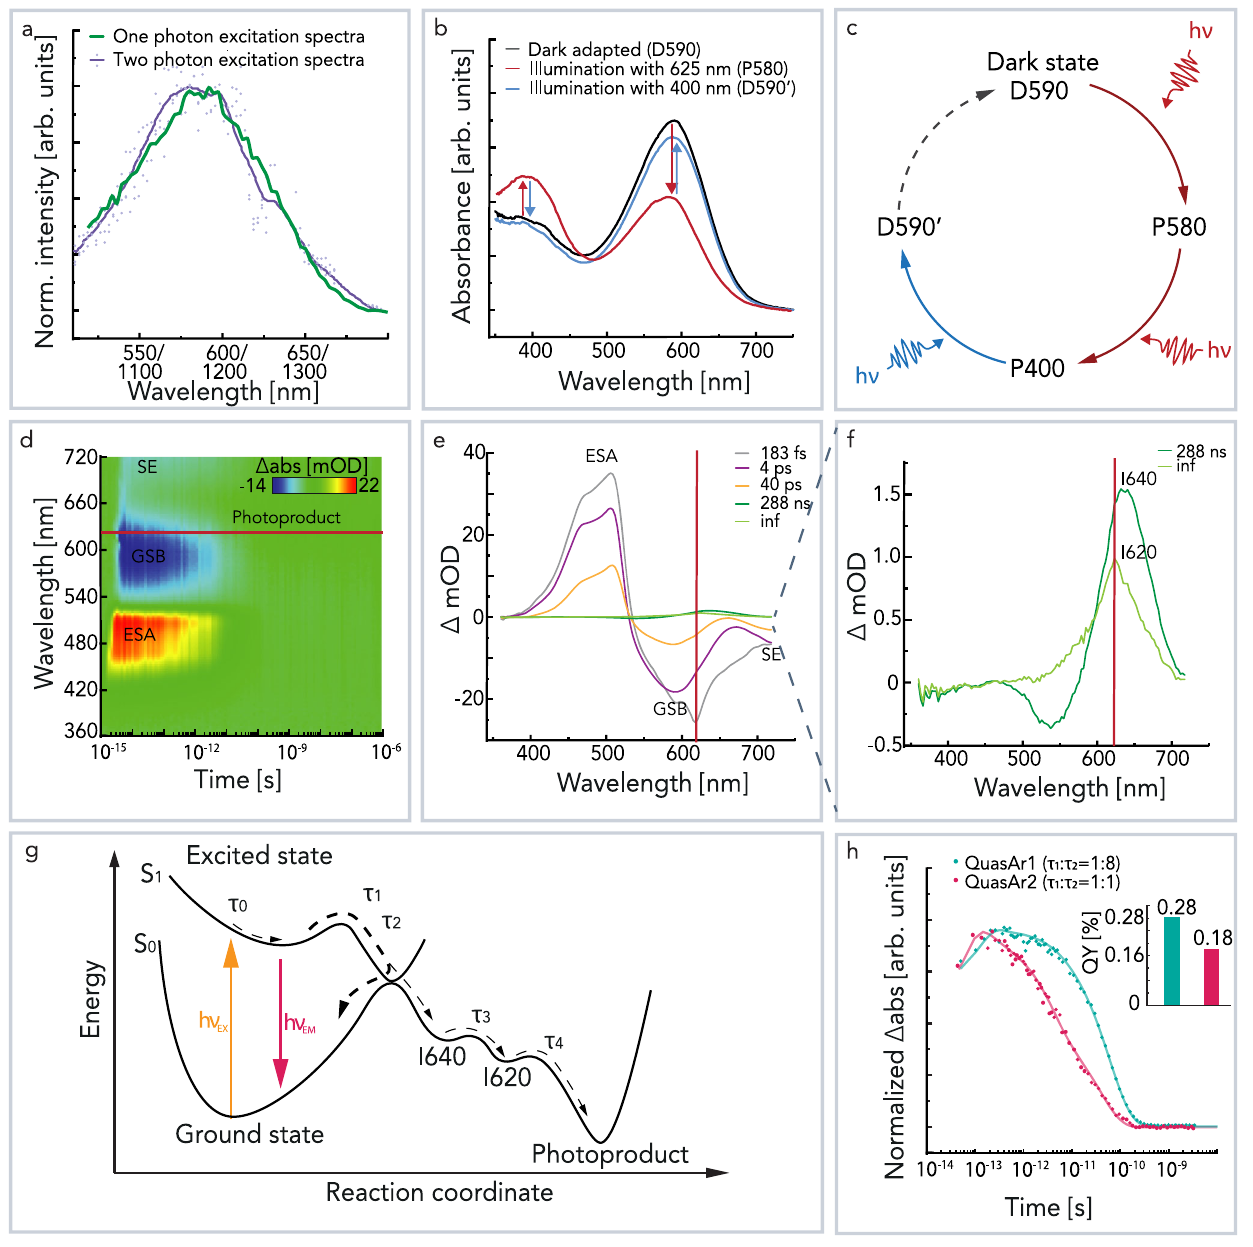
Fig. 1 | Study of the photocycle of QuasArs. a Excitation spectra of QuasAr2 compared between one-photon (green) and two-photon (purple) excitation. The two-photon excitation spectra data points are depicted with purple dots, and the resulting average is indicated with a solid line for visual guidance. The corre- sponding excitation wavelengths for two-photon spectra are noted below. b The QuasAr2 absorption spectra change after illumination with LED. The black curve shows IDS D590 absorption. The red curve shows a mixture of P580 and P400 photoproduct absorption spectra after sample illumination for 60s with 625nm. The blue curve shows a dark state-like recovered D590 ’ photoproduct absorption after subsequent 60s 400nm illumination. c Schematic representation of photo- productformationafterillumination. d – f Thefs-to- µ stransientabsorptionspectra of QuasAr2 obtained with fs pump-probe spectroscopy are shown in the middle row, where d reconstructed 3D plot of TAS, e evolution-associated difference